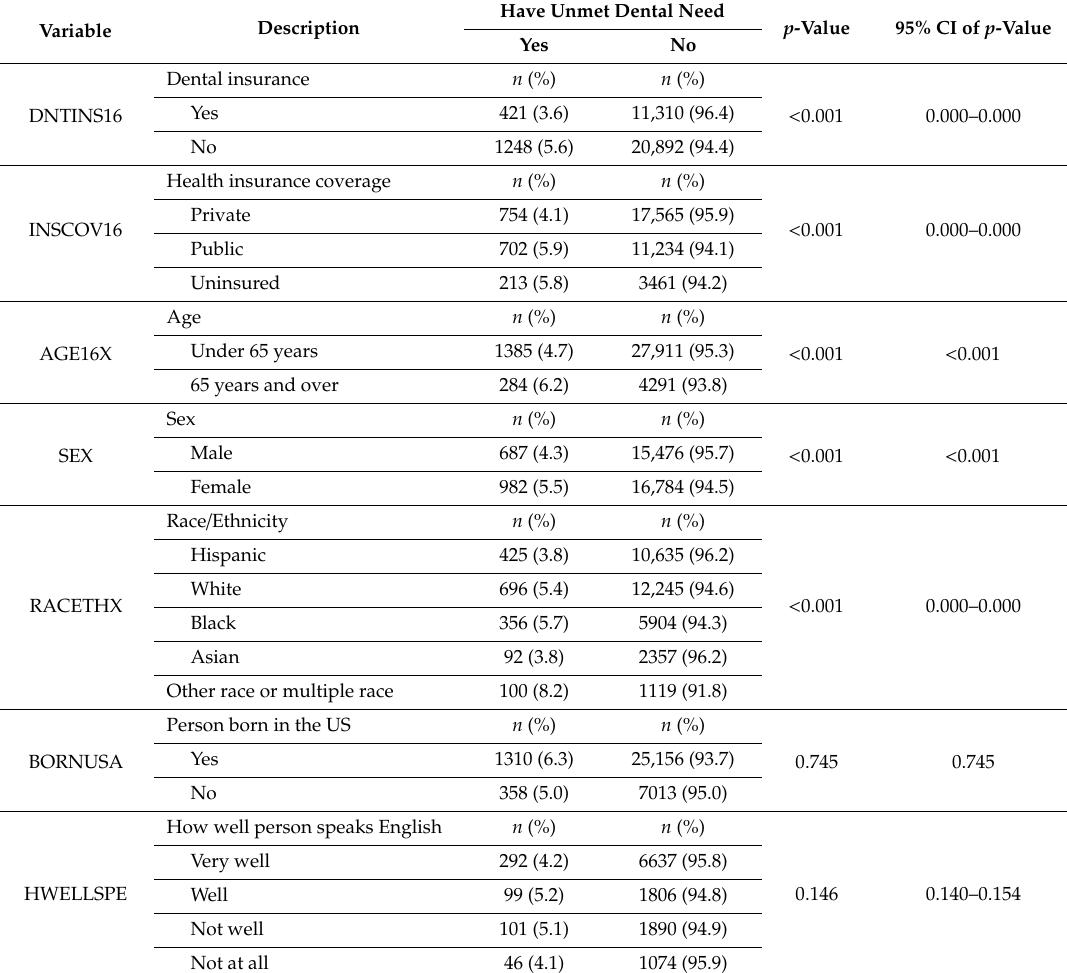
Table 2. Social determinants of health by unmet dental care